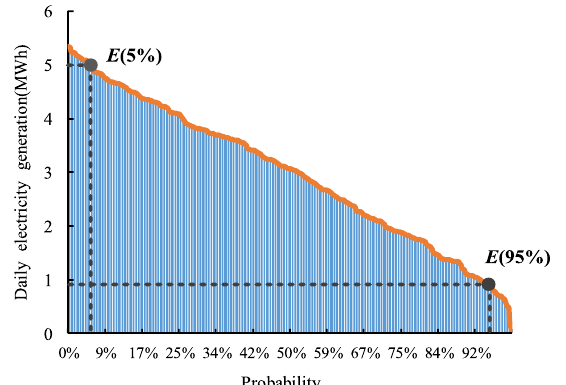
Fig. 3 Annual sustained electricity